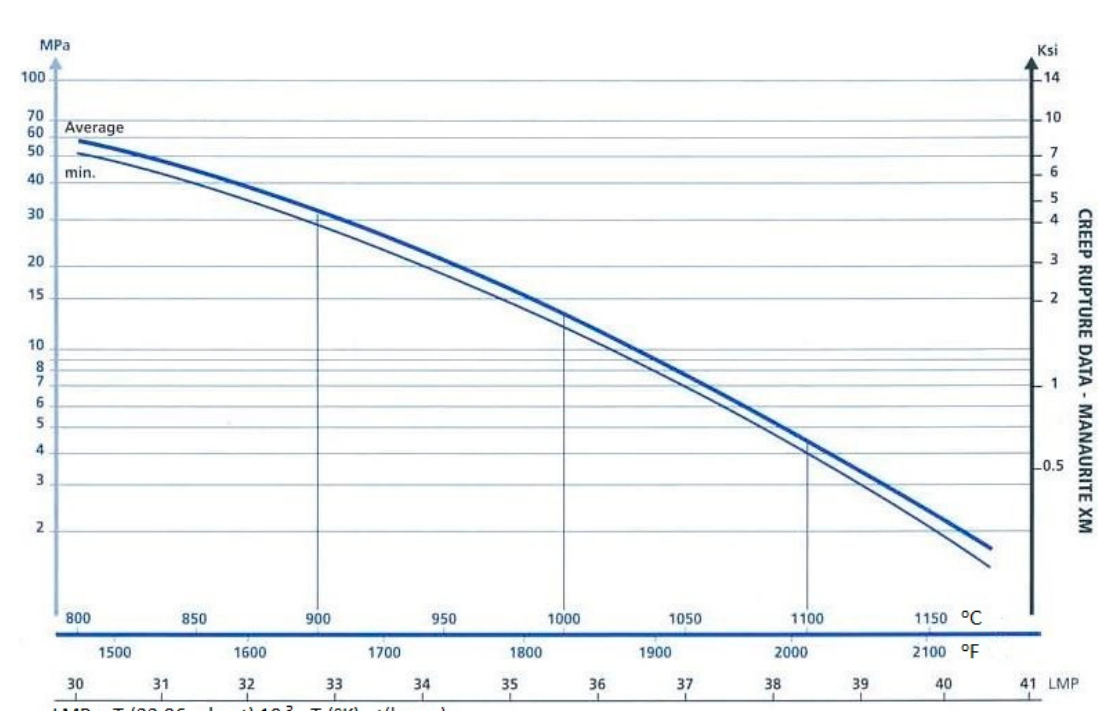
Figure 3. Correlation diagram of the Larson–Miller parameter [34].